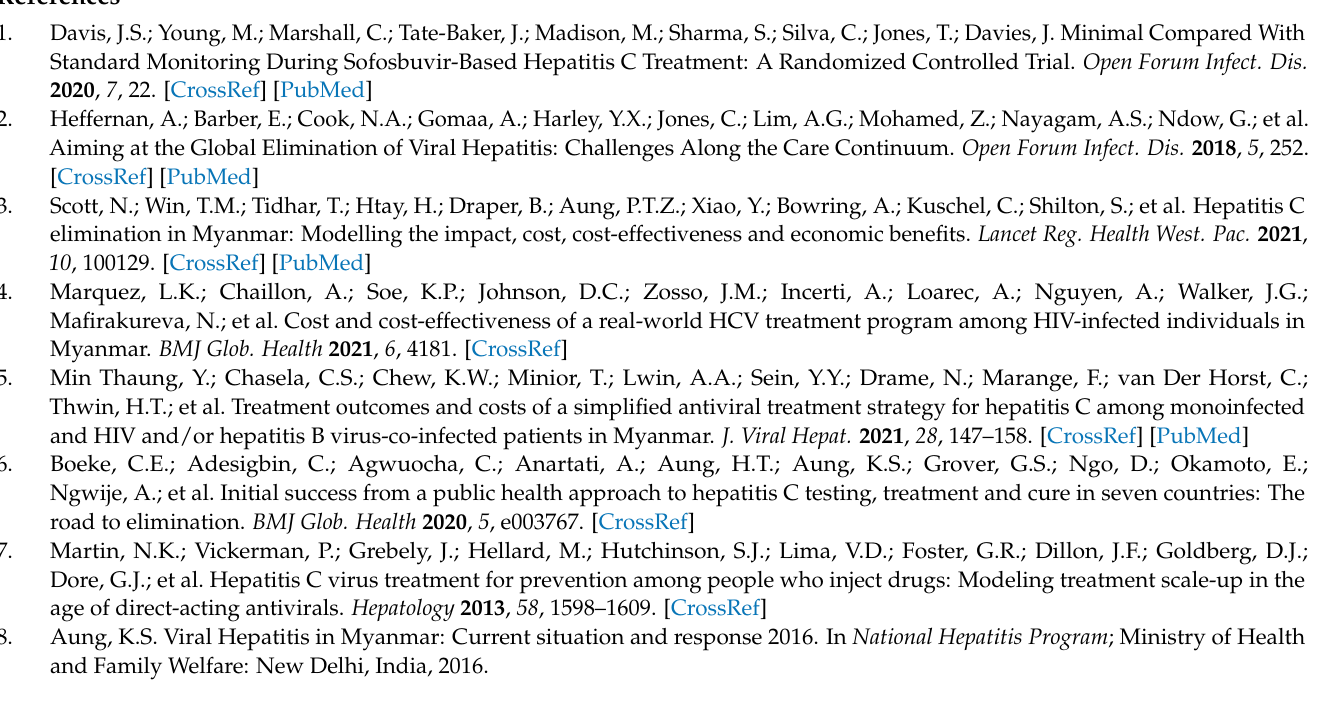
EQ-5D-EL Utility test: Performance status of participants, Table S2: Sensitivity and specificity of the Xpert HCV VL Fingerstick Assay for HCV detection compared with standard of care, performed as